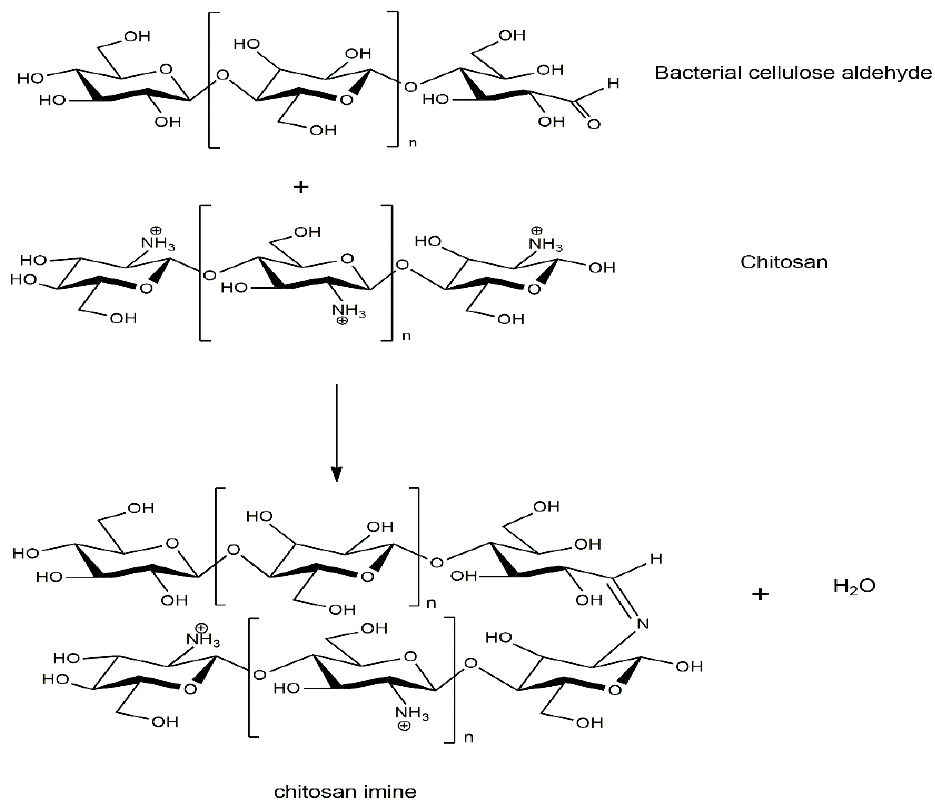
Scheme 1. Mannich reaction between chitosan and BC to produce yellowish Schiff base.